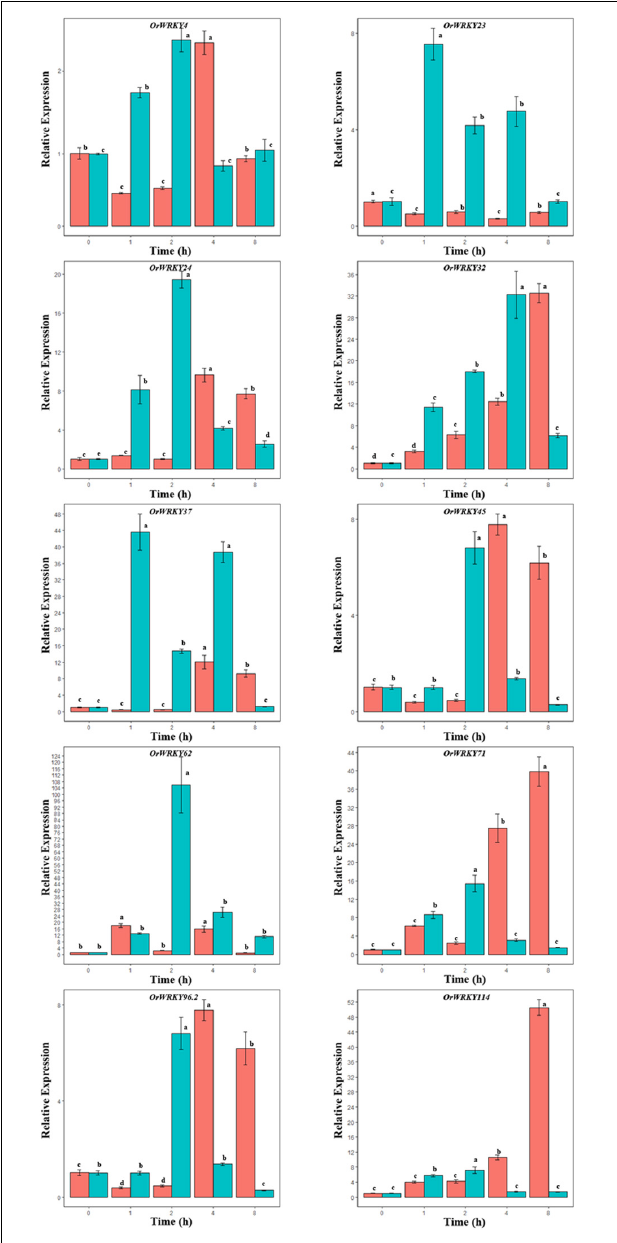
FIGURE 4 | The relative expression levels of the 10 selected genes based on quantitative real-time polymerase chain reaction (qRT-PCR) between leaves (red) and roots (green) tissues under salt stress treatment. Samples were collected at 0, 1, 2, 4, and 8 h after the treatment with salt solution. Note that the time point of 0 h was for the seedlings which were not treated with salt solution. Error bars indicate standard deviations (mean ± SD) of three independent replicates. The histogram bars labeled with different letters (a, b, c, d, and e) above histogram bars are significantly different [least significant difference (LSD) test, P <